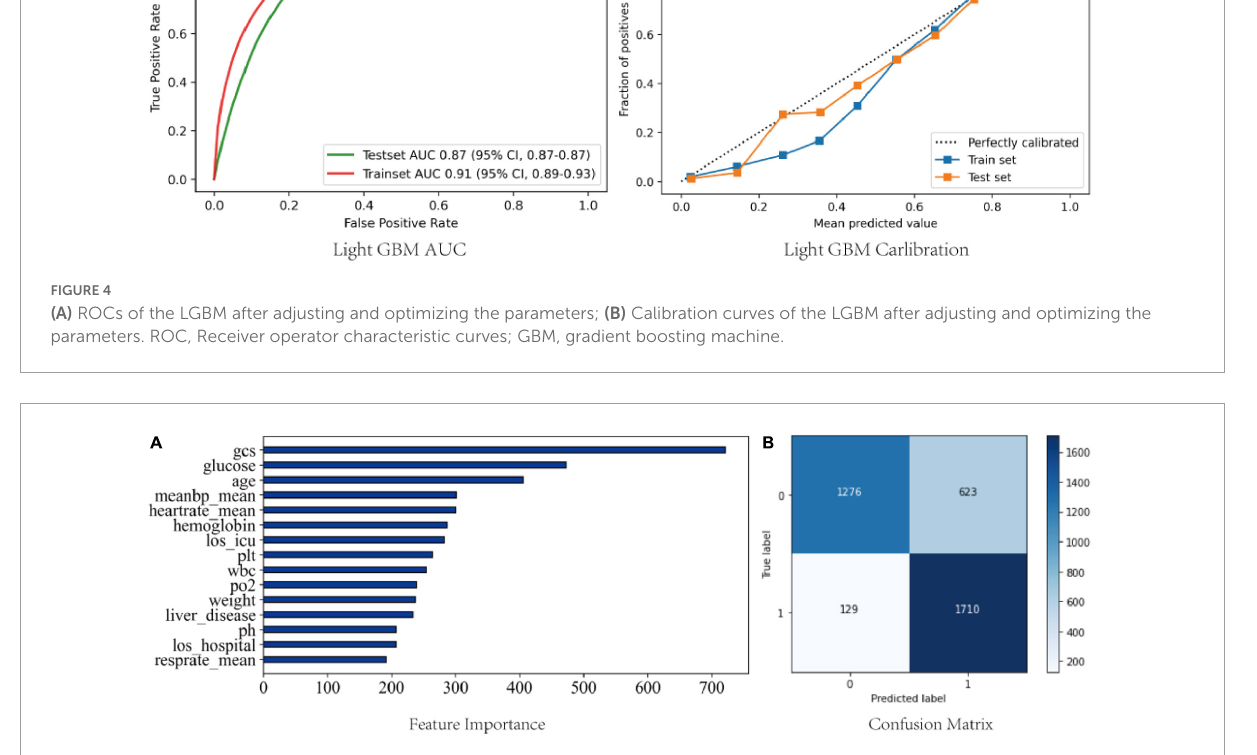
FIGURE5 (A) Feature importance from the LGBM model; (B) Confusion matrix from the LGBM model. meanbp_mean, mean arterial pressure is presented as mean daily values; heartrate_mean, mean heart rate; los_icu, length of stay in ICU; plt, platelet; wbc, white blood cell; los_hosiptal, length of saty in hospital; resprate_mean, mean respiratory